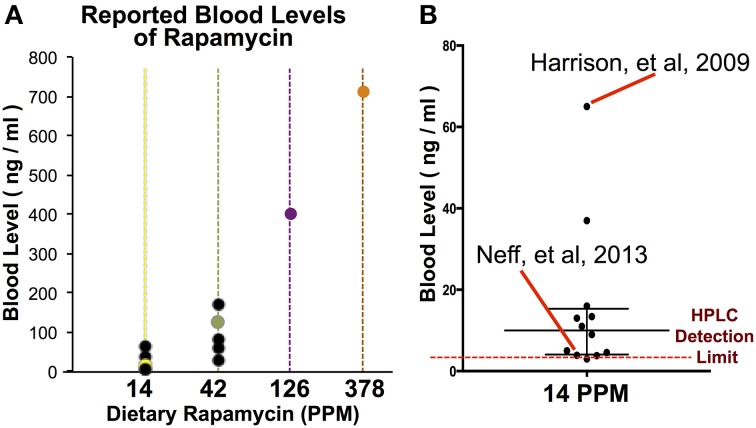
A comparison of rapamycin blood levels in studies using dietary rapamycin treatment. (A) Blood levels of rapamycin reported in studies using dietary treatment (black datapoints) and in our study (colored datapoints). (B) A comparison of reported blood levels in studies using 14 PPM dietary rapamycin with the initial ITP report (Harrison et al.) and the 2013 report suggesting few benefits to aging parameters (Neff et al.) indicated. Bar and whiskers represent median and interquartile range of published blood levels for 14 PPM rapamycin. Reported limit of detection by HPLC indicated by dashed line.